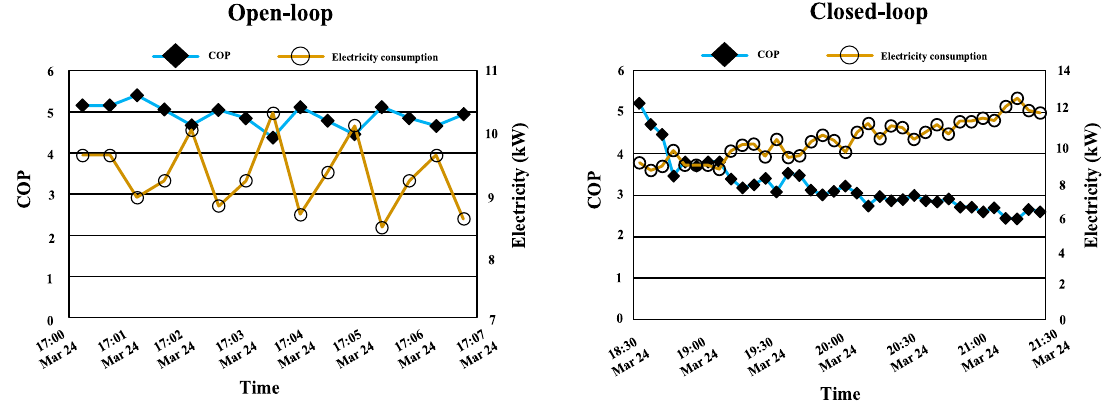
Figure 4. The COP and energy consumption for the open-loop and closed-loop systems.